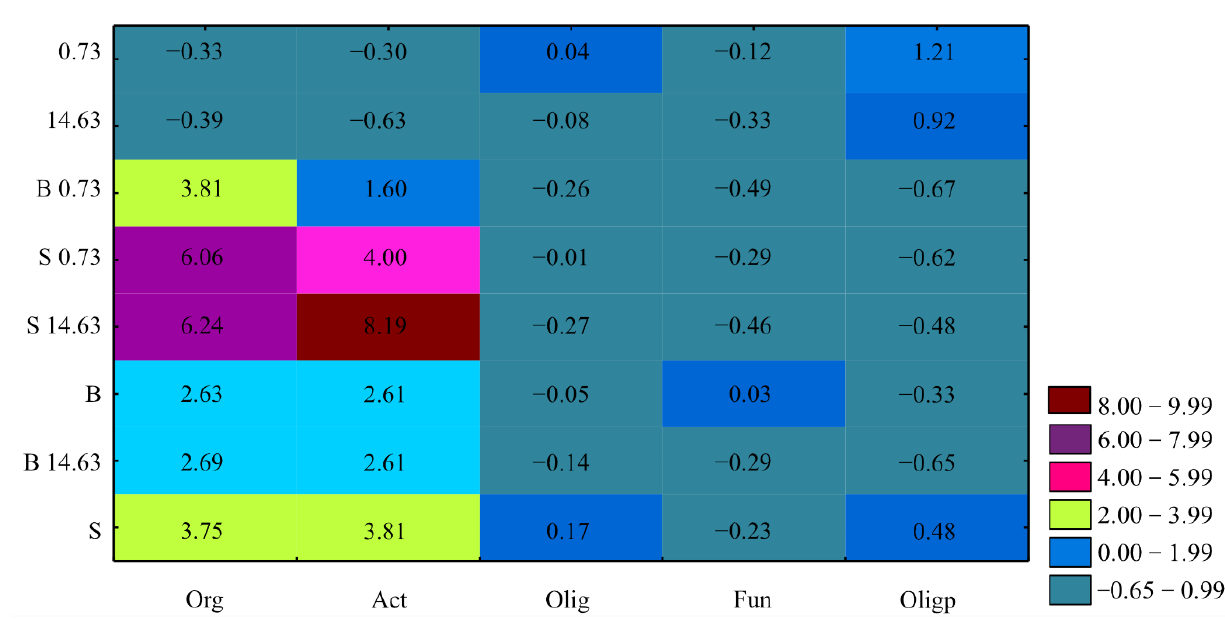
Figure 4. Impact index (IF) of the Successor T 550 SE, bentonite and straw on the microbial counts in soil. Org—organotrophic bacteria; Act—actinobacteria; Olig—oligotrophic bacteria; Fun—fungi; Oligp—sporeforming oligotrophic